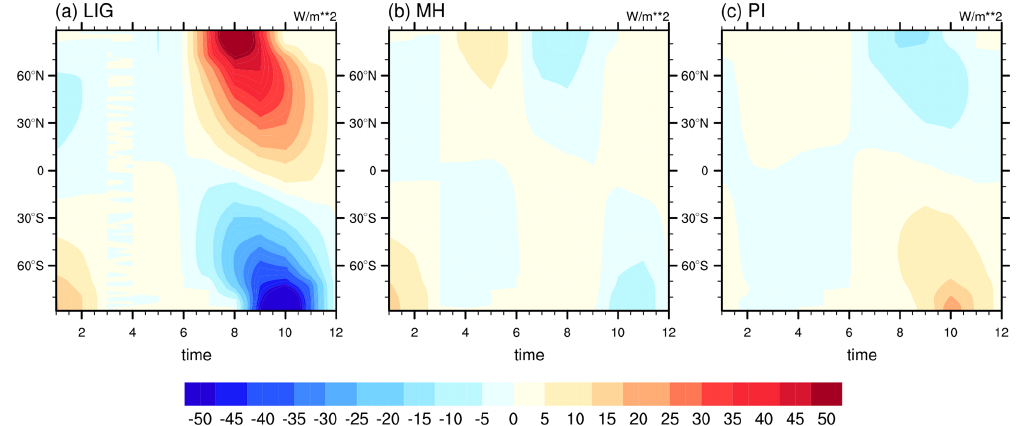
Figure 2. Insolation anomalies between angular and classical calendar for (a) LIG, (b) MH, and (c) PI.